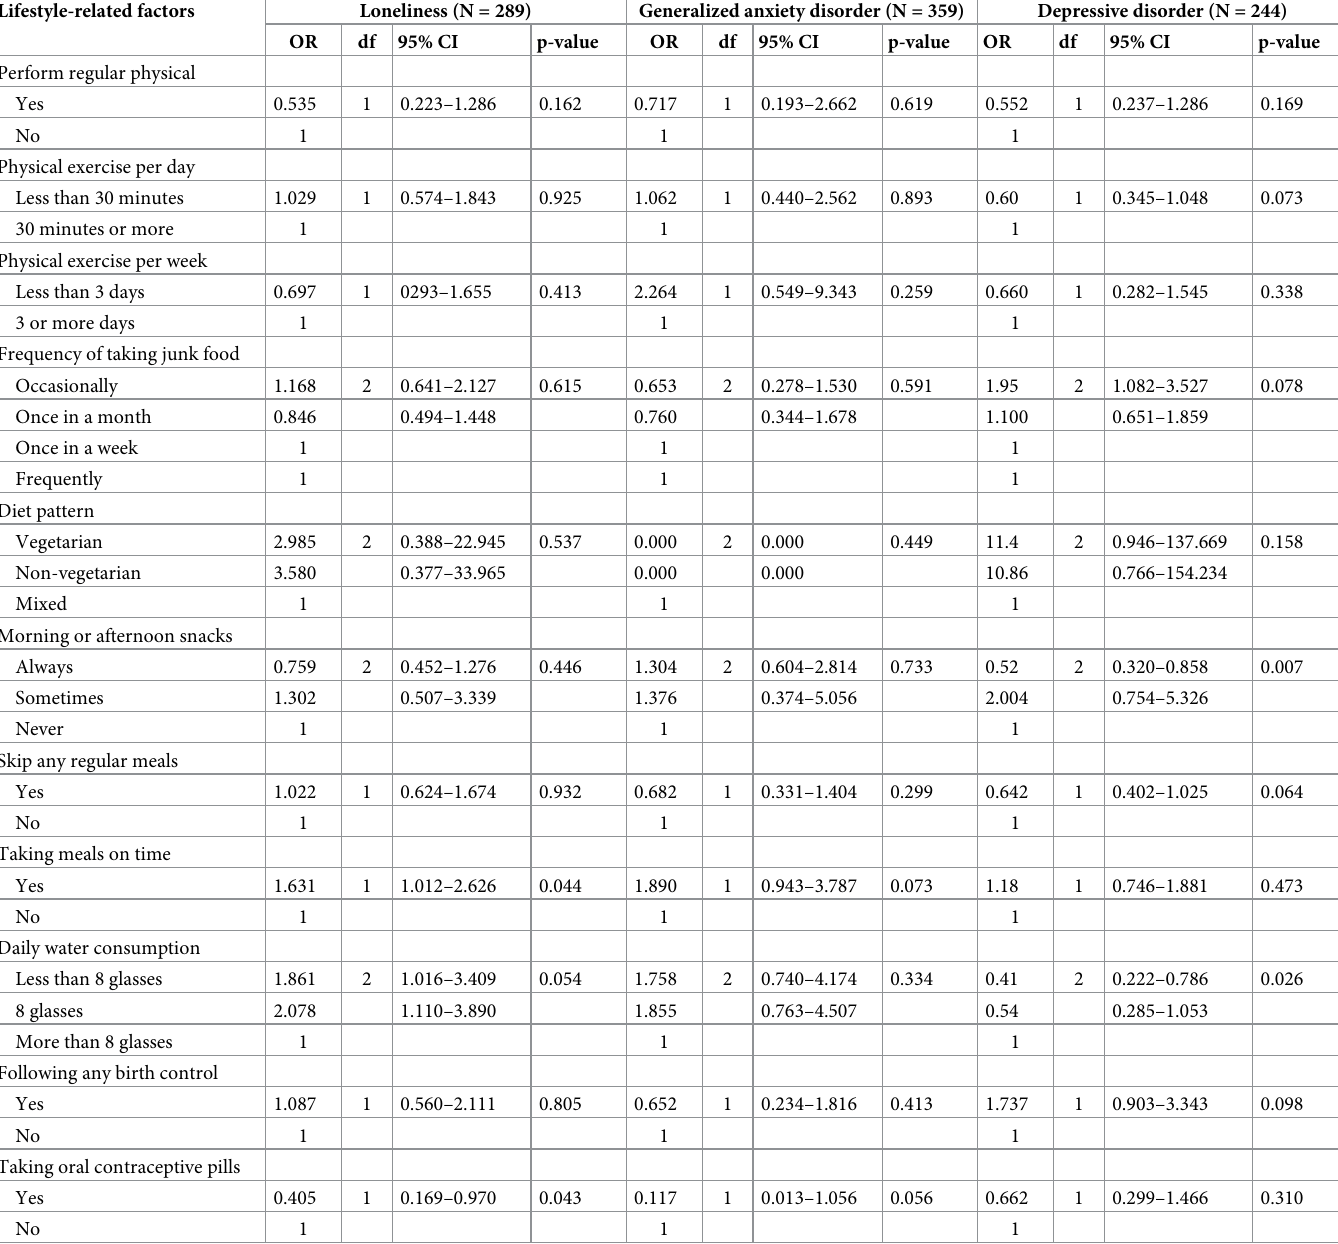
Table 4. Regression analysis of lifestyle-related factors and their association with mental health problems among the patients suffering from the polycystic ovarian syndrome. Lifestyle-related